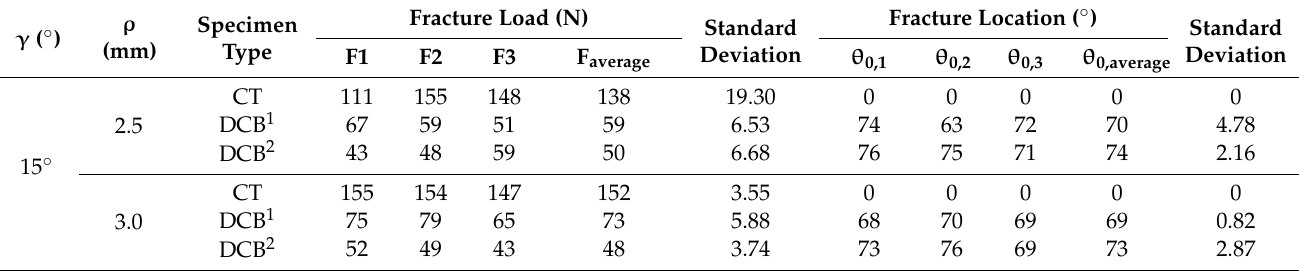
Table 2. Experimental fracture loads and fracture angle of the VO-notched